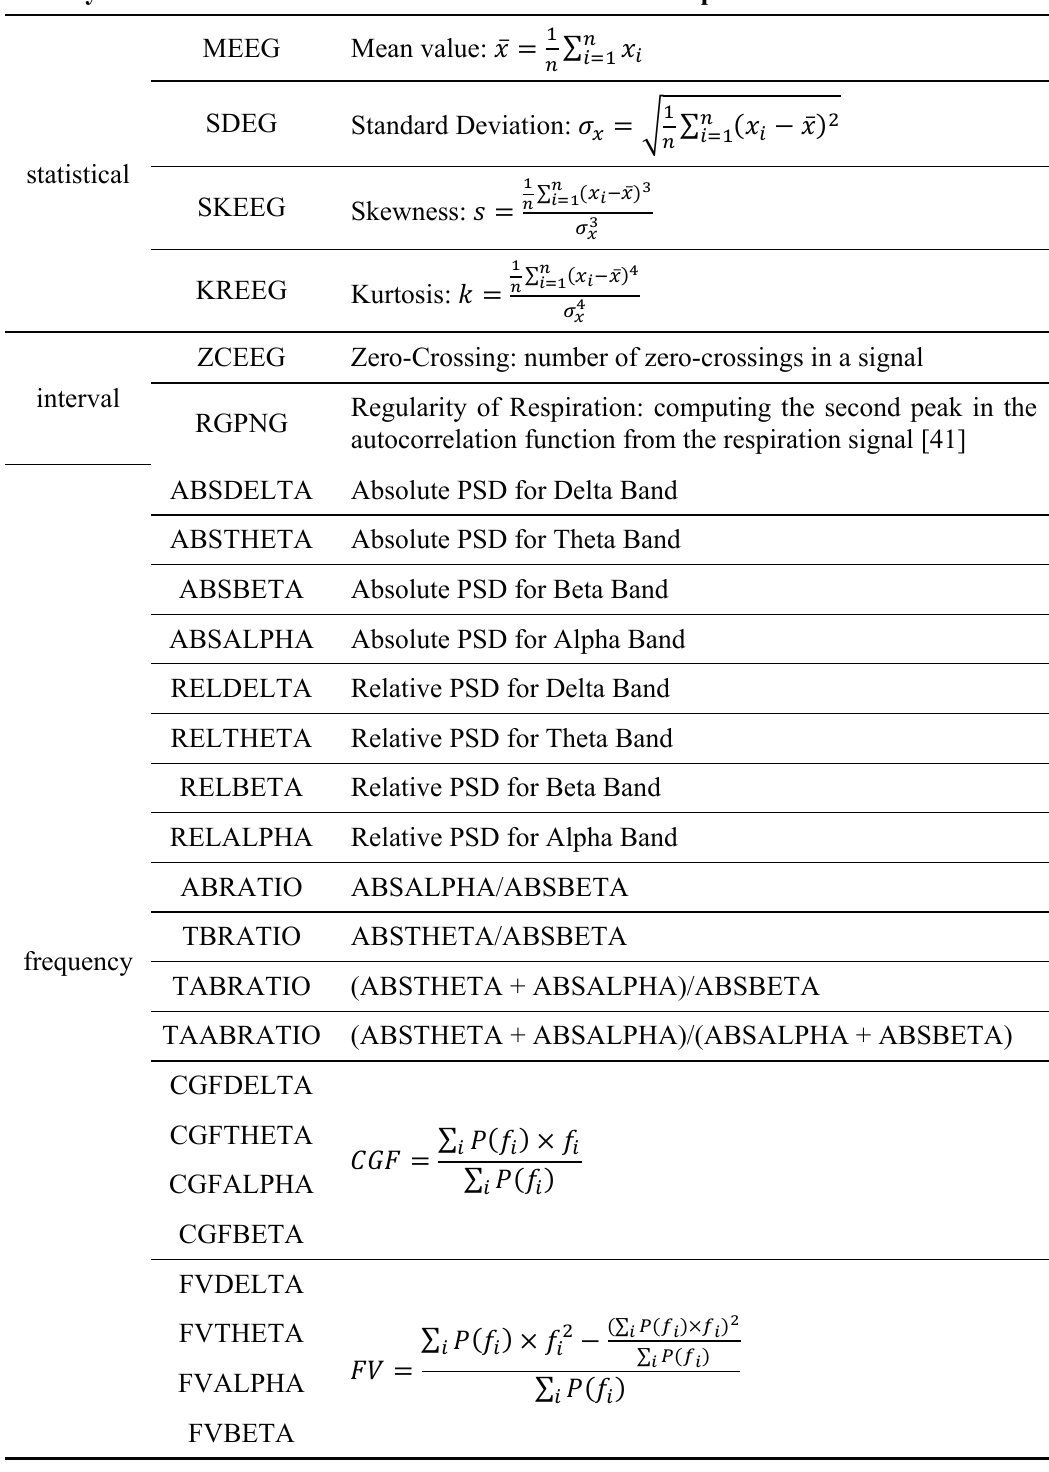
Table 3. Extracted features from filtered EEG signals and respiration signals that can be categorized by ( a ) statistical analysis; ( b ) interval analysis; and ( c ) frequency